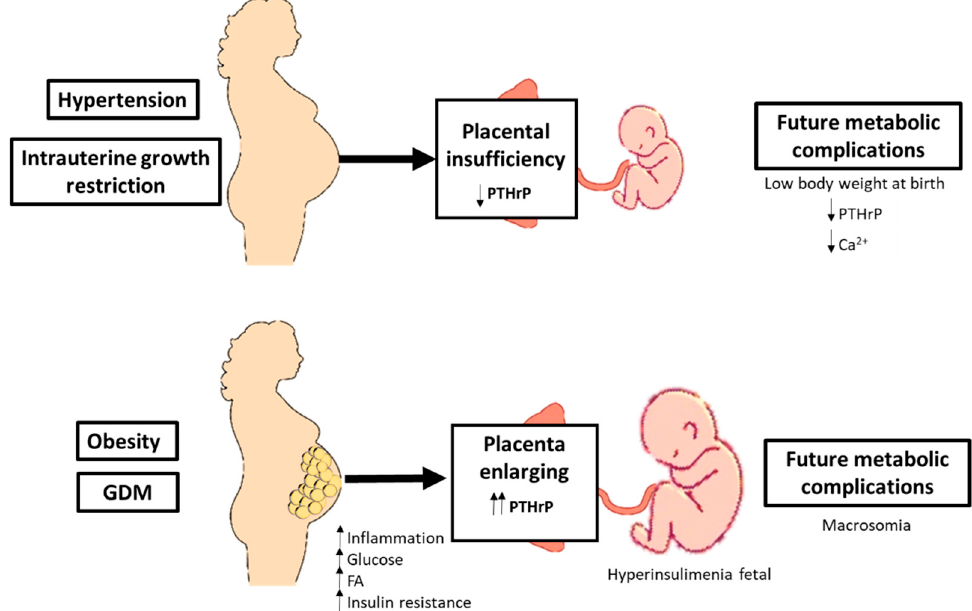
Figure 3. PTHrP, adipose tissue and pregnancy. FA: Fatty acids; GDM: Gestational diabetes mellitus; PTHrP: Parathyroid hormone ‐ related protein.